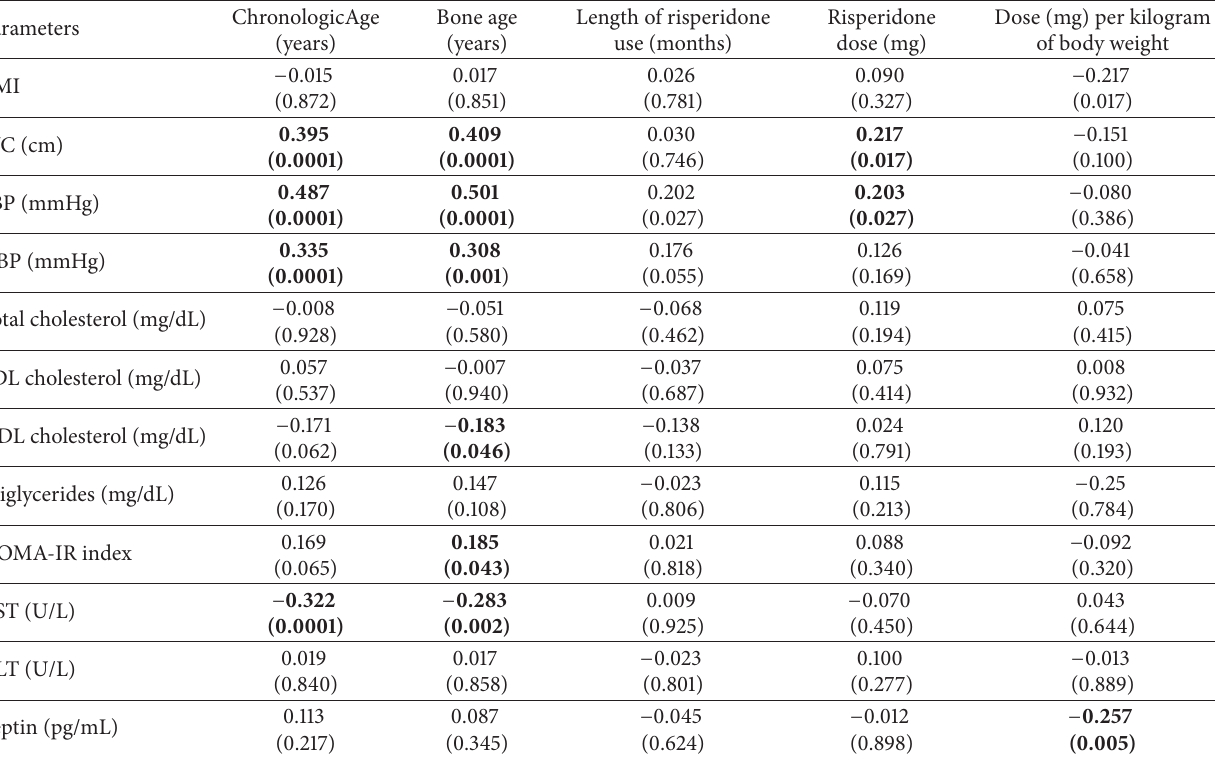
Table 3: Values of Spearman correlation test and significance level ( 𝑝 ) between clinical and laboratory parameters with age, duration of use, and dose of risperidone in the study